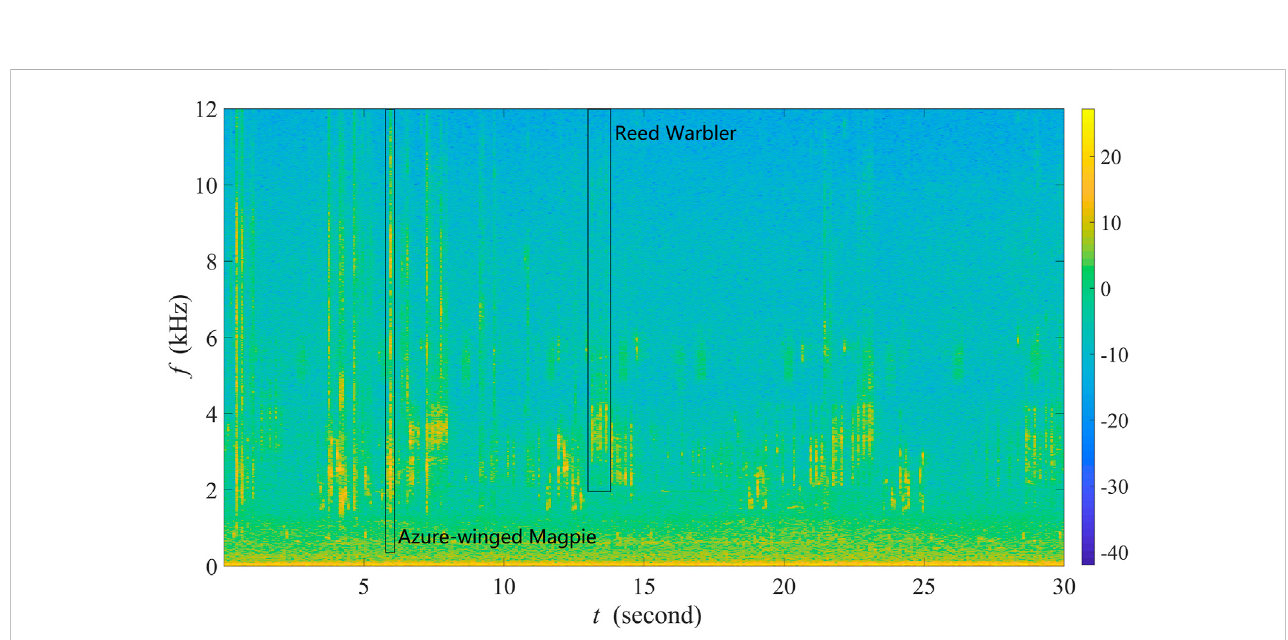
FIGURE 2 Spectrogram of a 30-s recording as a representative example collected in site A at Jiuli Lake National Wetland Park, Xuzhou, Jiangsu Province, China.